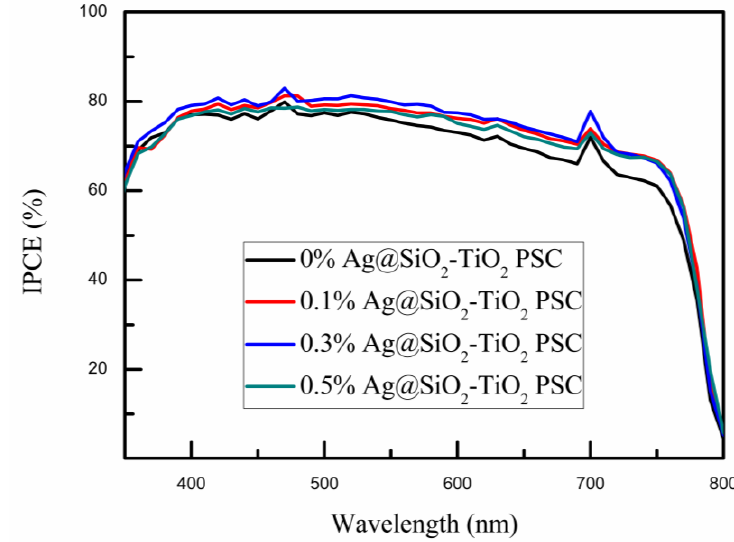
Figure 8. IPCE spectra of PSC devices based on mesoporous TiO 2 film mixed with different amounts of Ag@SiO 2 NPs.